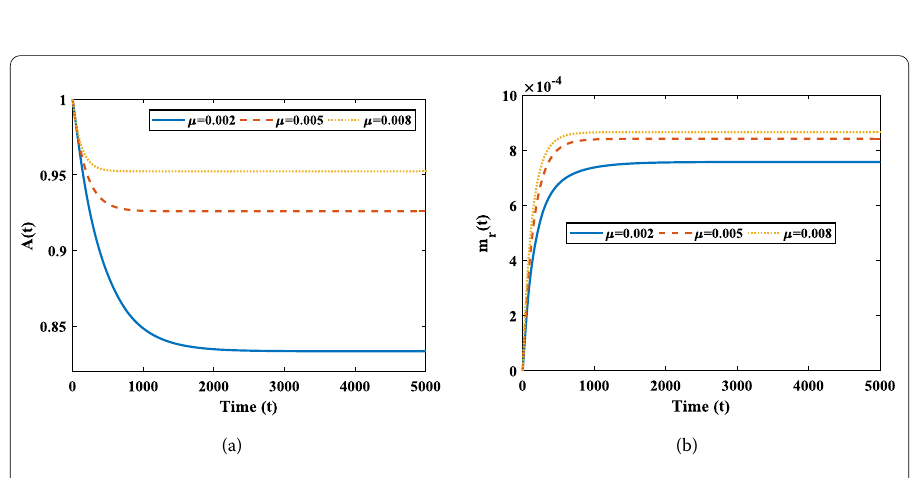
Figure 4 Effect of parameter μ on time-dependent reliability indices. ( a ) Availability for different μ ; ( b ) Renewal frequency for different